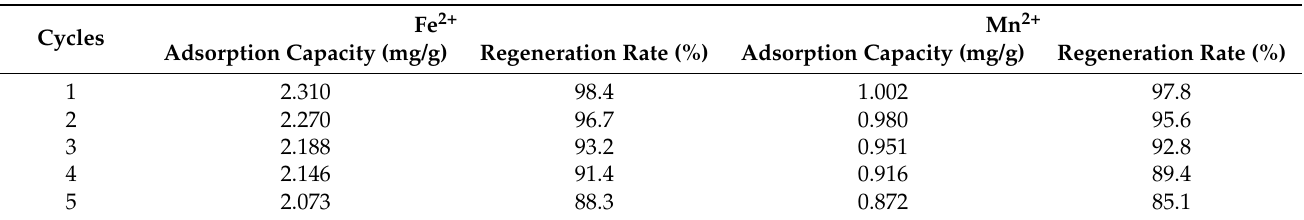
Table 5. Regeneration capacity of the IHA/TM composite adsorbent.